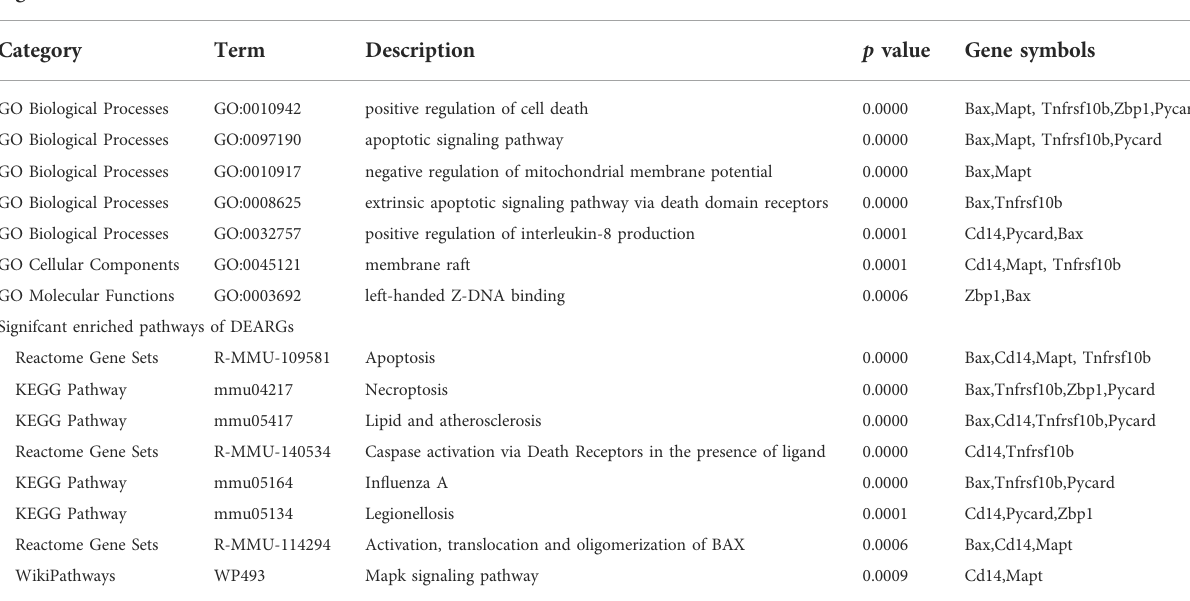
TABLE 2 Functional enrichment analysis of differentially expressed apoptosis-related genes